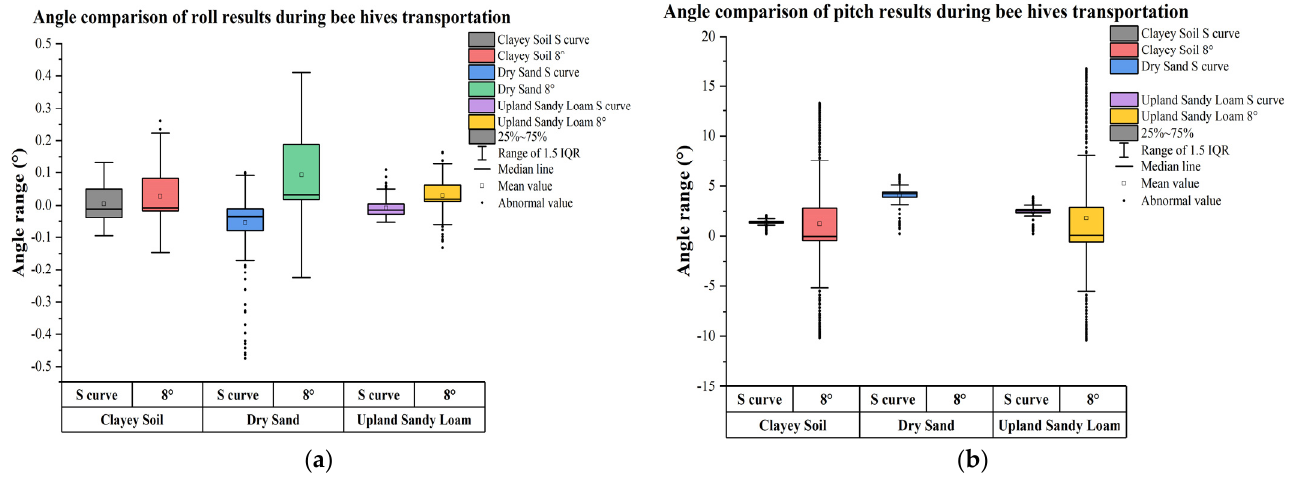
Figure 25. Box plot of ( a ) variation in roll values under each pavement condition when the vehicle is fully loaded with beehives and ( b ) variation in pitch values under each pavement condition when the vehicle is fully loaded with beehives.